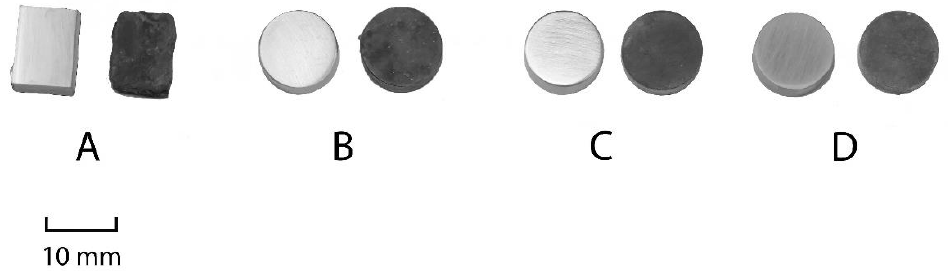
Figure 2. Appearance of the alloys before (left images) and after (right images) contact with Bi–Li alloy at 650 °C for 100 h: Hastelloy ® B-3 Alloy ( A ); TZM ( B ); MoW10 ( C ); MoW30 ( D ).